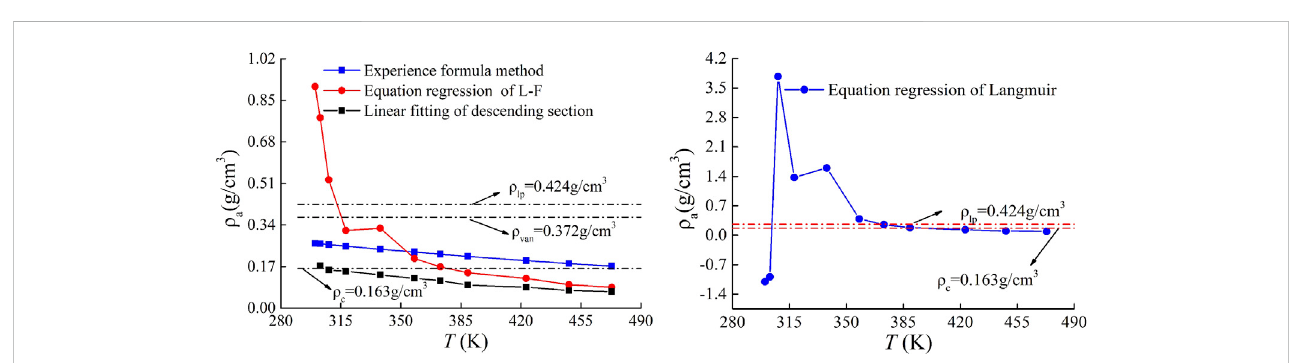
FIGURE 3 Adsorbed density curve from different calculation